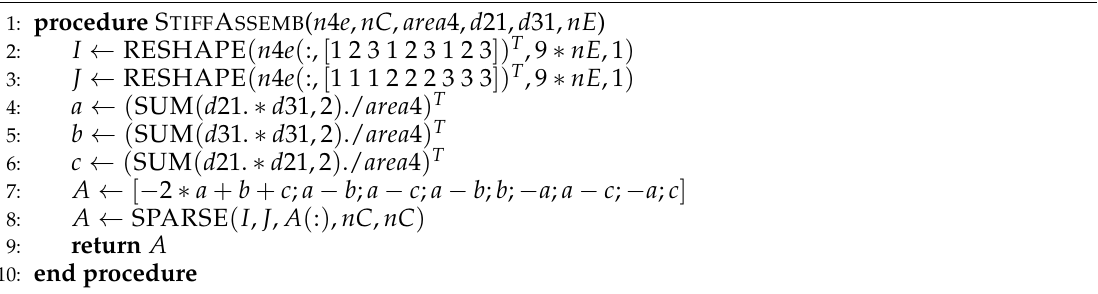
Algorithm 8 Assembling the stiffness matrix with vectorization.